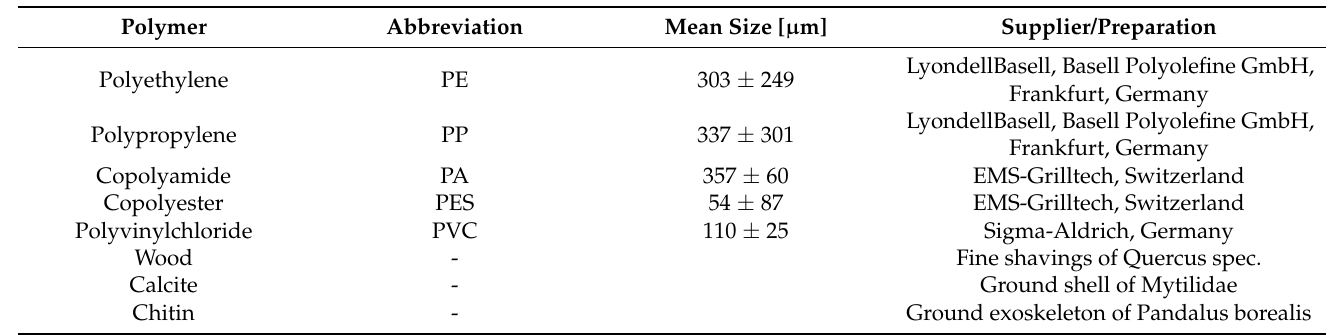
Table 6. Microplastics and natural particles used for the investigation of the selectivity of the new Nile red